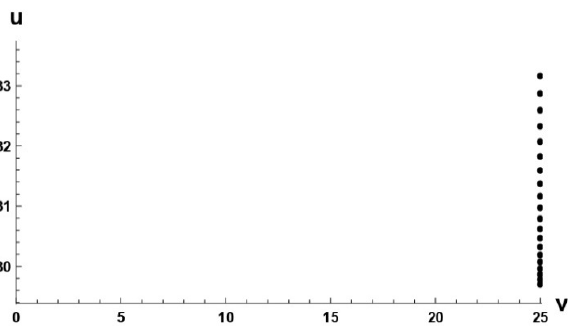
Figure 7. Path of contact of spur gear with 0.1° (1.7 mrad) of in-plane angular misalignment.